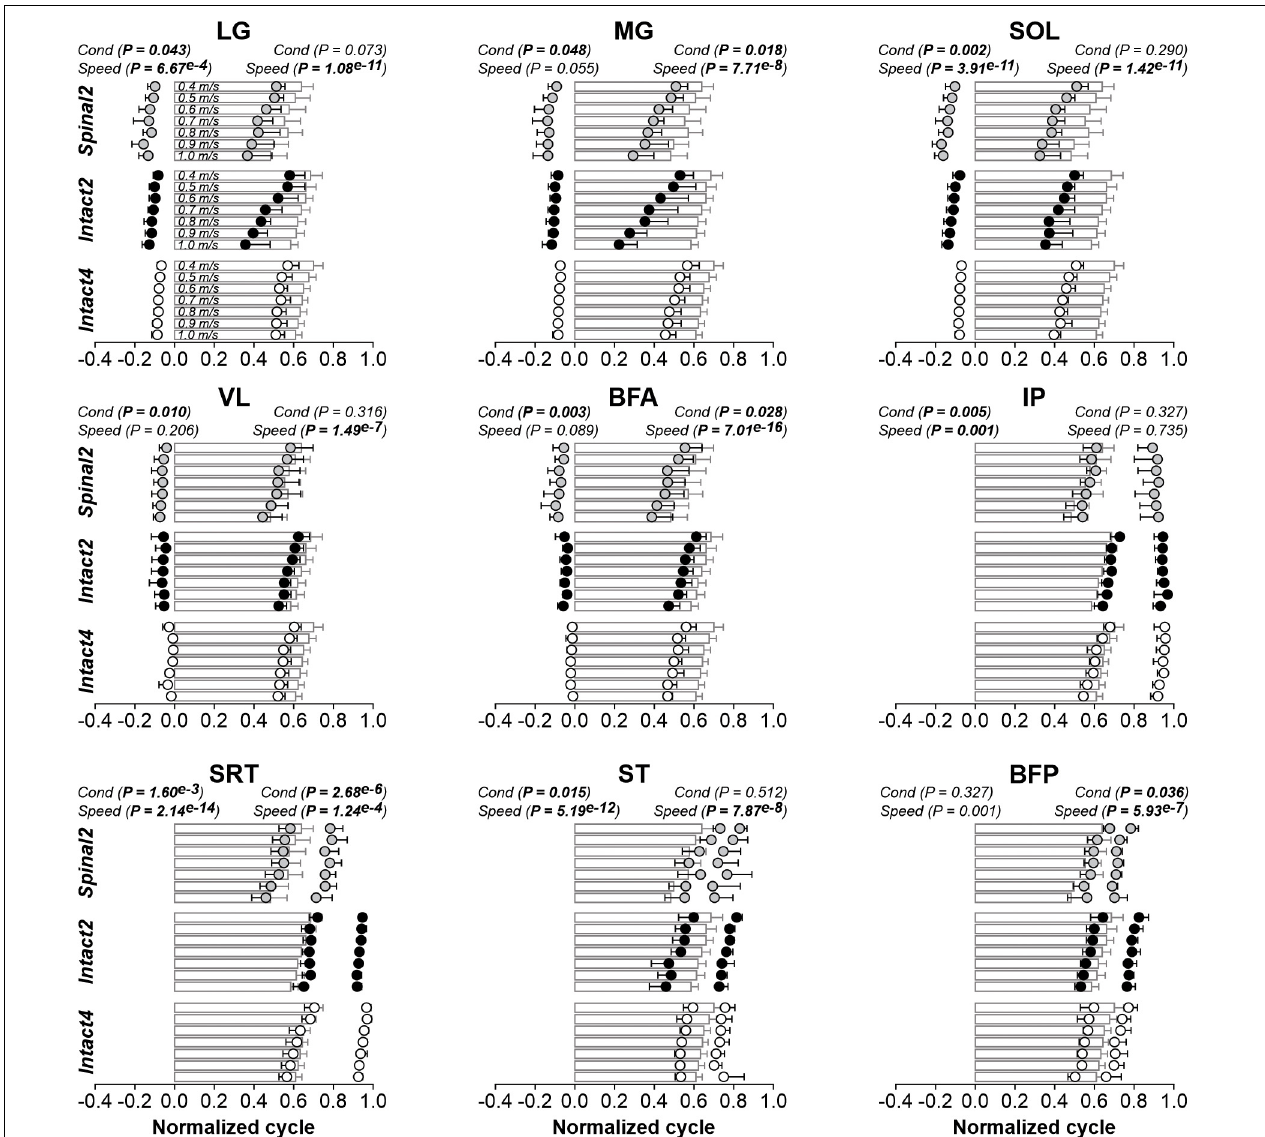
FIGURE 7 | Modulation of EMG phasing during quadrupedal or hindlimb-only locomotion in intact and spinal cats across speeds. The figure shows burst onsets and offsets from nine hindlimb muscles normalized to the cycle during Intact4, Intact2 and Spinal2 conditions at seven treadmill speeds. At each speed, 6–15 cycles were averaged per cat. Data points represent burst onsets and offsets. Horizontal bars represent averaged stance durations normalized to stance onset. Each data point or bar indicates the mean ± SD for the group. P values comparing conditions (Cond) and speeds are indicated (main effects of repeated-measures ANOVA). For muscle abbreviations, see Figure 5